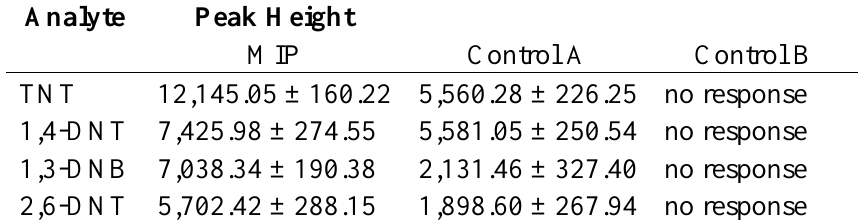
Table 1. Peak heights of SERS spectral bands associated with the nitrate stretching modes of various nitro-aromatic compounds.